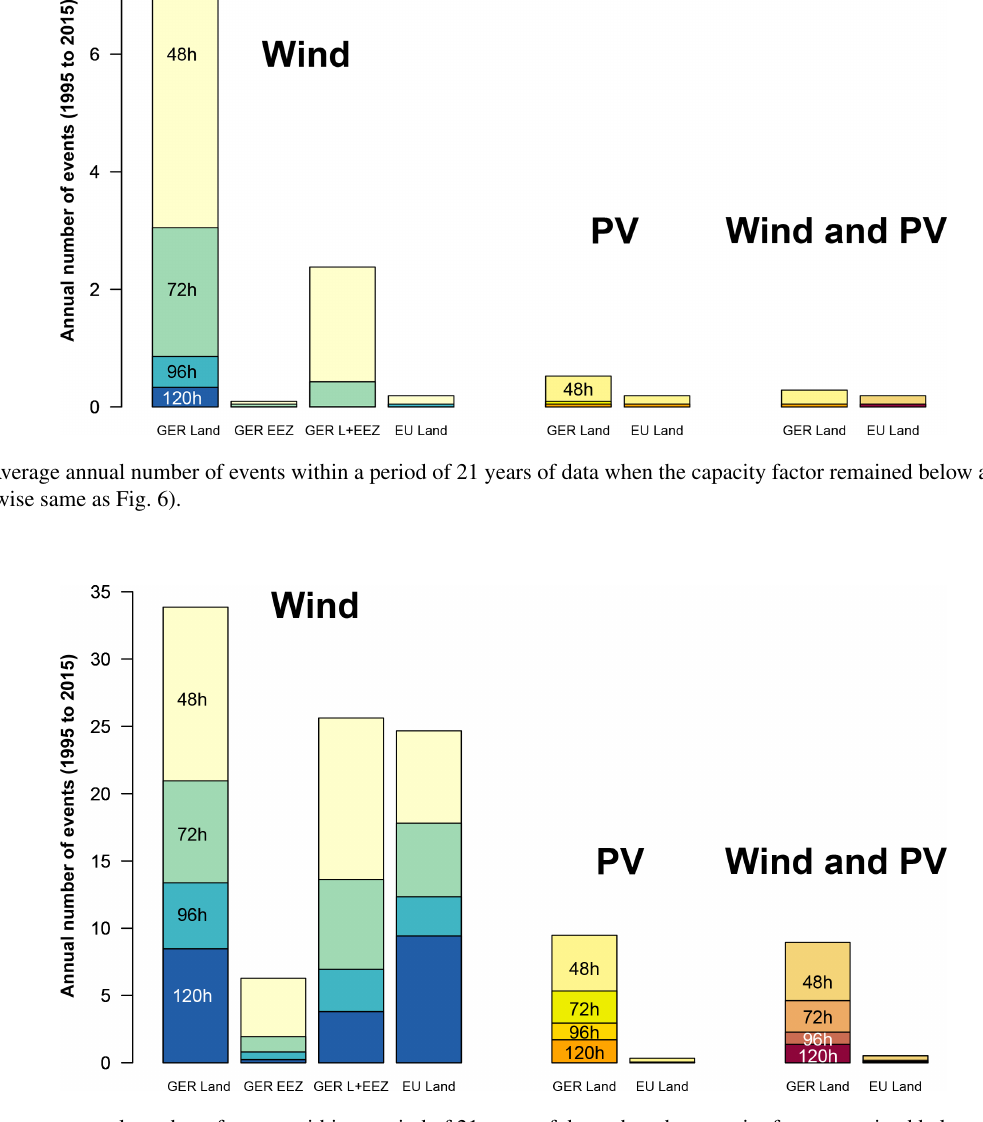
Figure A2. Average annual number of events within a period of 21 years of data when the capacity factor remained below a threshold value of 15% (otherwise same as Fig.